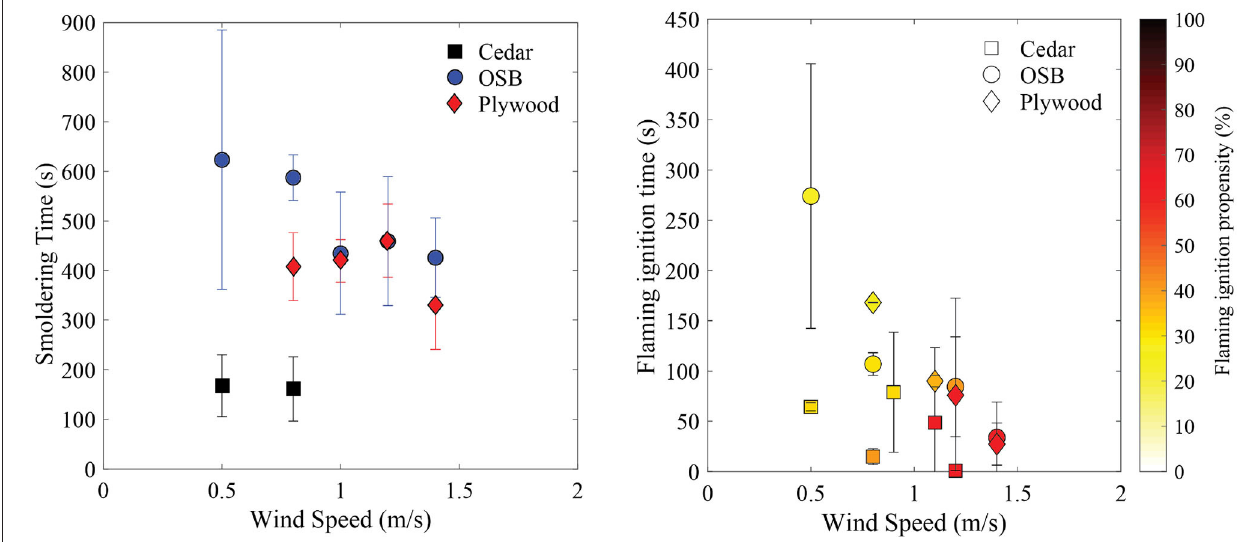
FIGURE 9 | Time to smoldering ignition (left) and time to flaming ignition (right) as a function of wind speed for three fuels and 16 g firebrand piles. Each point is averaged with error bars representing the standard deviation between values from individual tests. The flaming propensity is the ratio of tests that transitioned to flaming over those that did not; darker colors indicate a higher likelihood of transition to